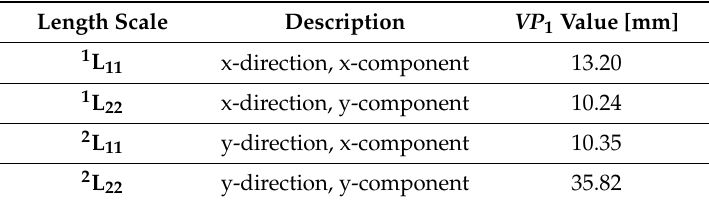
Table 1. Summary of calculated length scales at VP 1 .